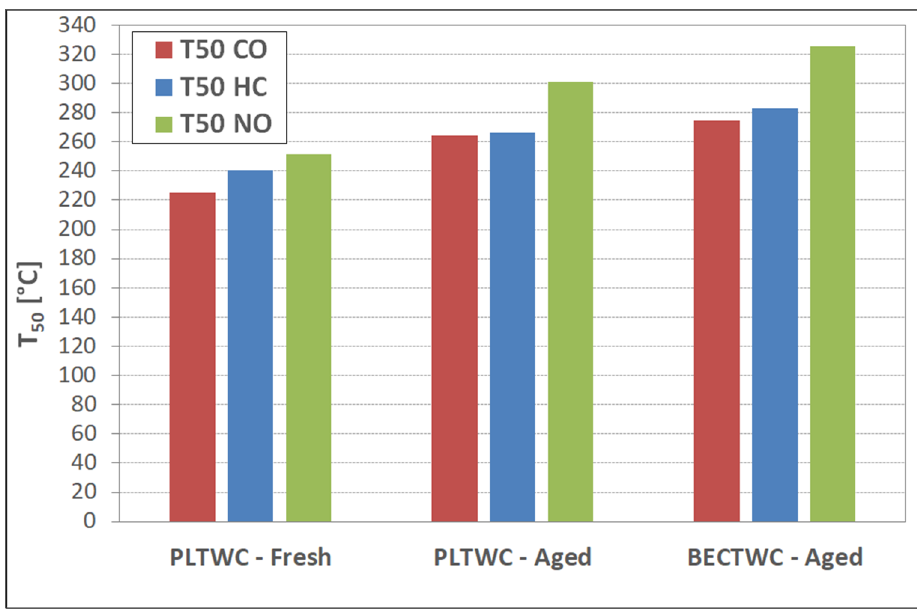
Figure 7. TWC light-off test: T 50 (CO-HC-NO)—average values.